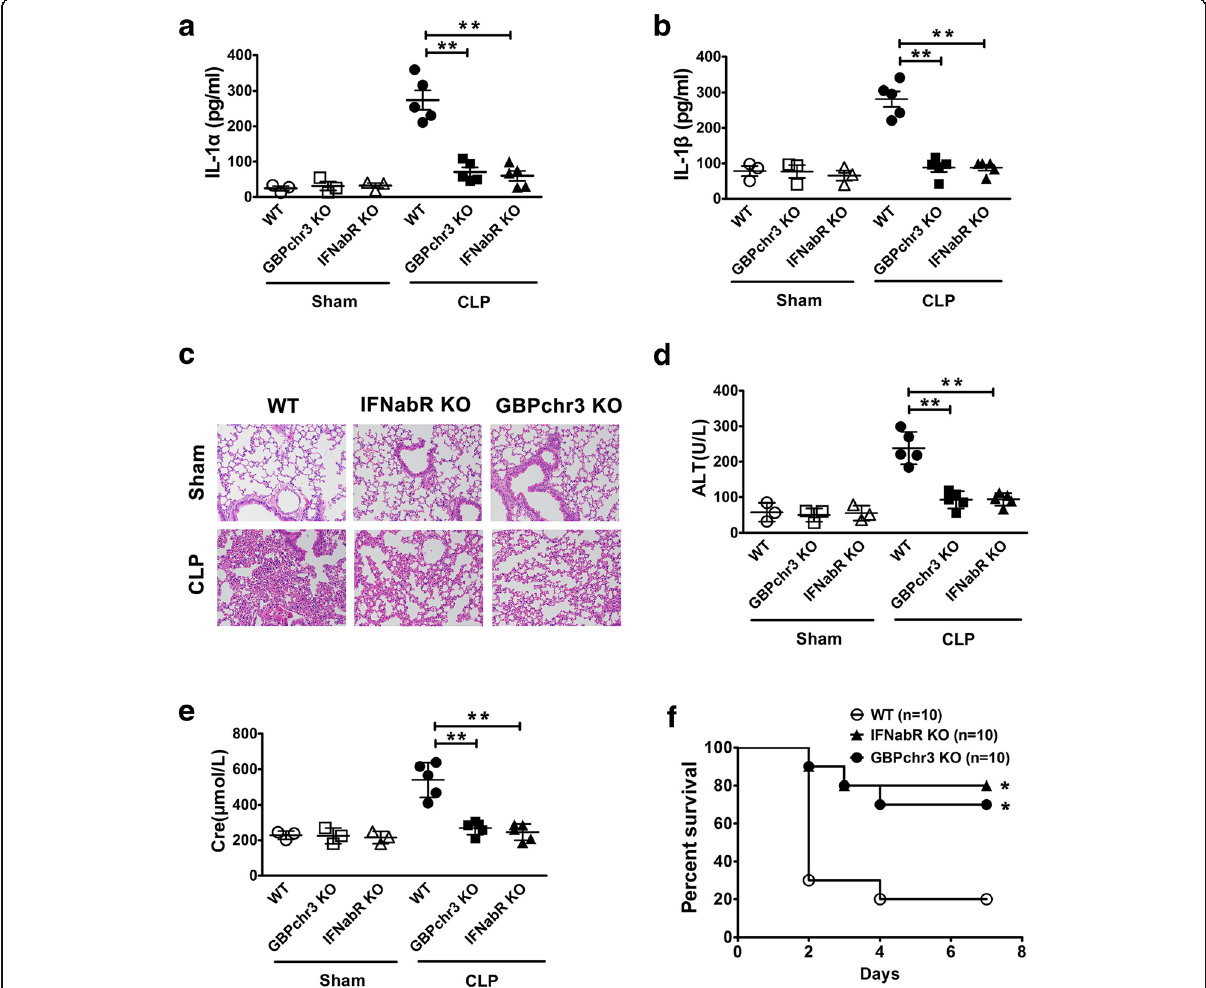
Fig. 6 Type 1 IFNs-GBPs pathway is critical for caspase-11-dependent immune responses, organ injury and lethality in sepsis. a-b Serum IL-1 α and IL-1 β levels from mice of indicated genotypes subjected to either CLP or sham operation. c H&E staining of the lungs from mice of indicated genotypes ( n = 5) subjected to either CLP or sham operation. d-e The serum alanine aminotransferase (ALT) and creatinine (Cre) levels from mice of indicated genotypes were subjected to either CLP or sham operation. f Kaplan Meier survival curves for the indicated genotypes subjected to either CLP or sham operation. * P <0.05; ** P <0.01; *** P <0.001 (Student ’ s t-test and log-rank test for survival). Graphs show the mean ± SD. Data